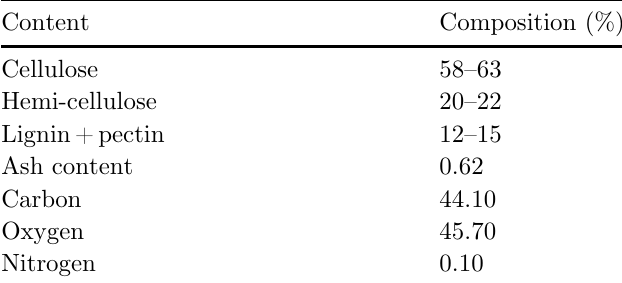
Table 1. Chemical composition of raw jute fi bers from